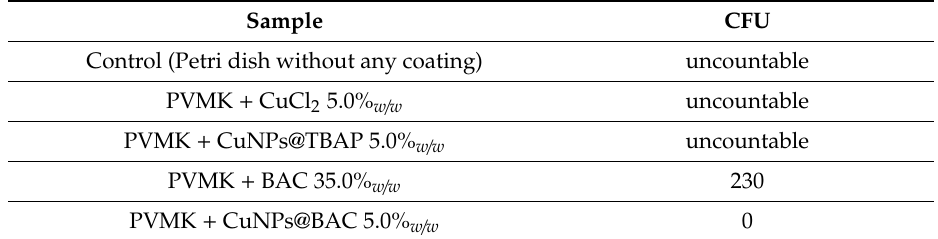
Number of colony forming units (CFU) of E. Coli ATCC 25922 grown on di ff erent composite coatings. Sample CFU Control (Petri dish without any coating) uncountable